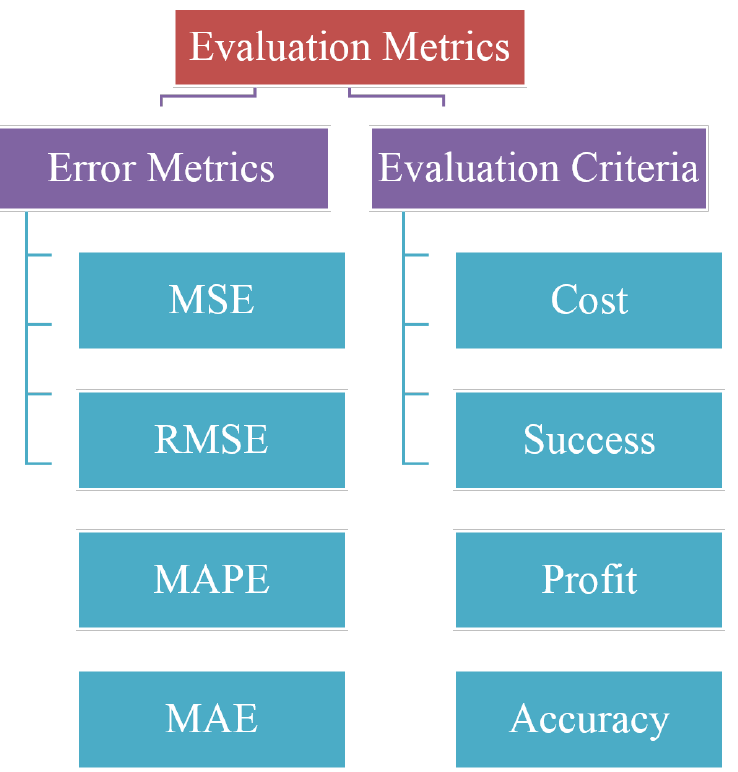
Figure 3. Commonly used evaluation